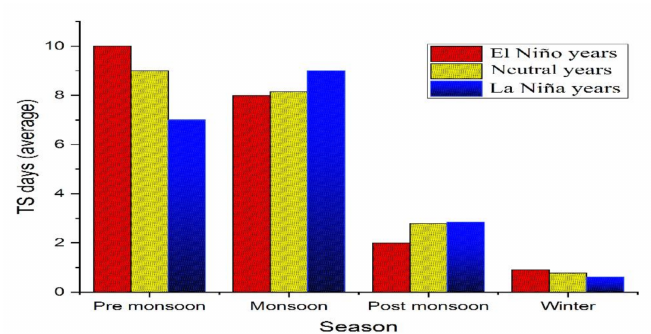
Figure 10. Seasonal (premonsoon, monsoon, postmonsoon and winter) variation of annual average TS days during the El Niño (indicated as red), neutral (yellow) and La Niña (blue)